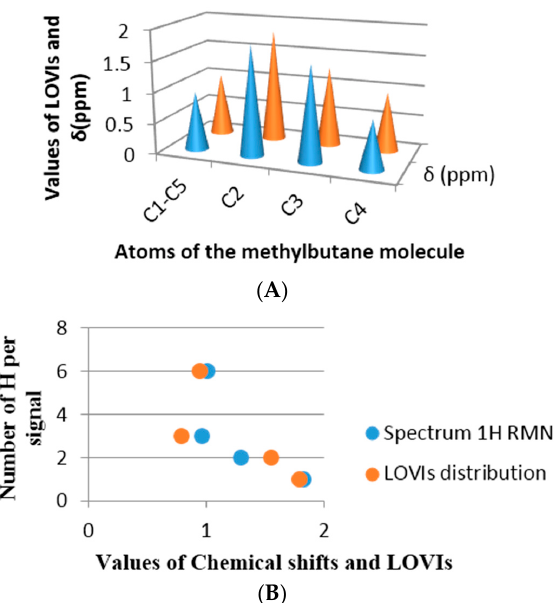
Figure 9. Methylbutane. ( A ) Equivalence between LOVIs values and the chemical shift in ppm; ( B ) Quantity of protons that provoke the signal vs . LOVIs and ppm.